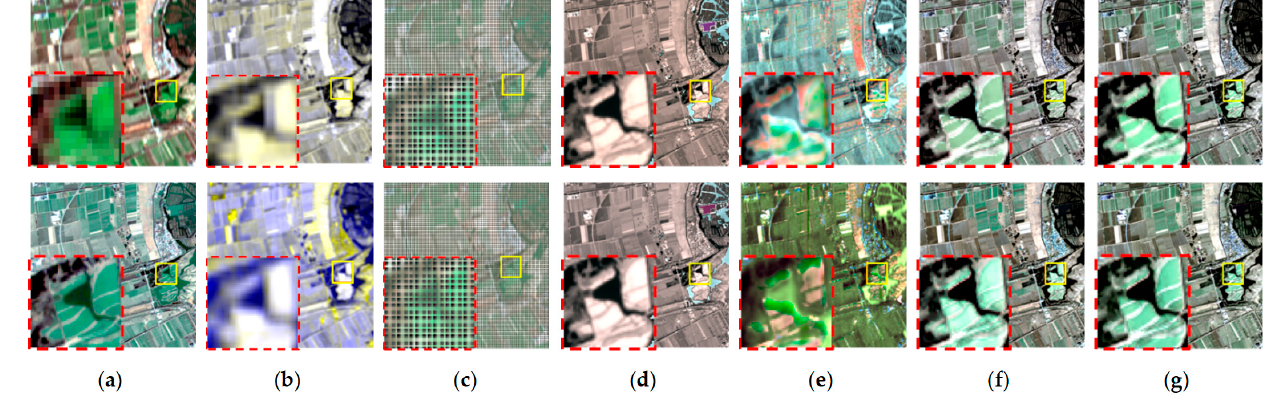
Figure 8. The SRR results before and after denoising in ZY-1 02D HSI. (( a ) column) Noised HSI (1st row), MSI (2nd row). ( b – g ) Columns are SRR results before denoising (1st rows) and after denoising (2nd rows) of MIAE, FuVar, ECCV14, ICCV15, CNMF, and the proposed method.